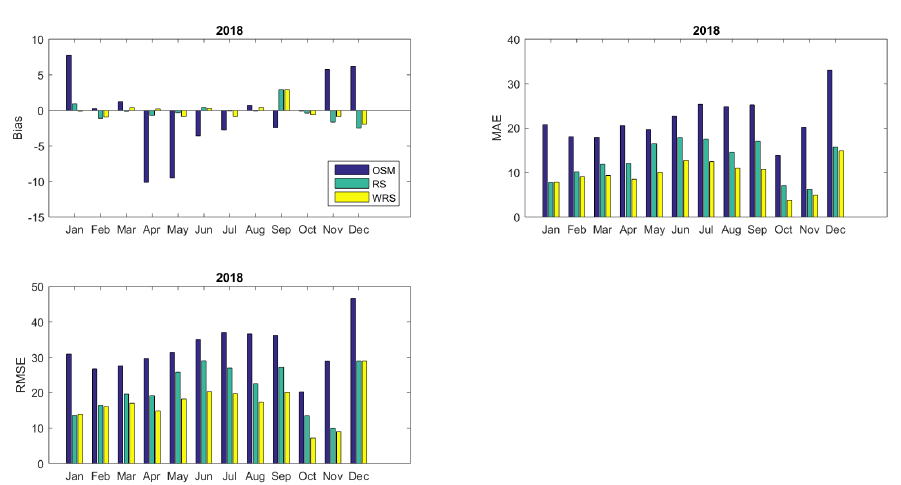
Figure 11. Statistical error indices for the Reshaped Simulation Model (RS) and the Weighted Reshaped Simulation Model (w-RS) for the year 2018 (per month).